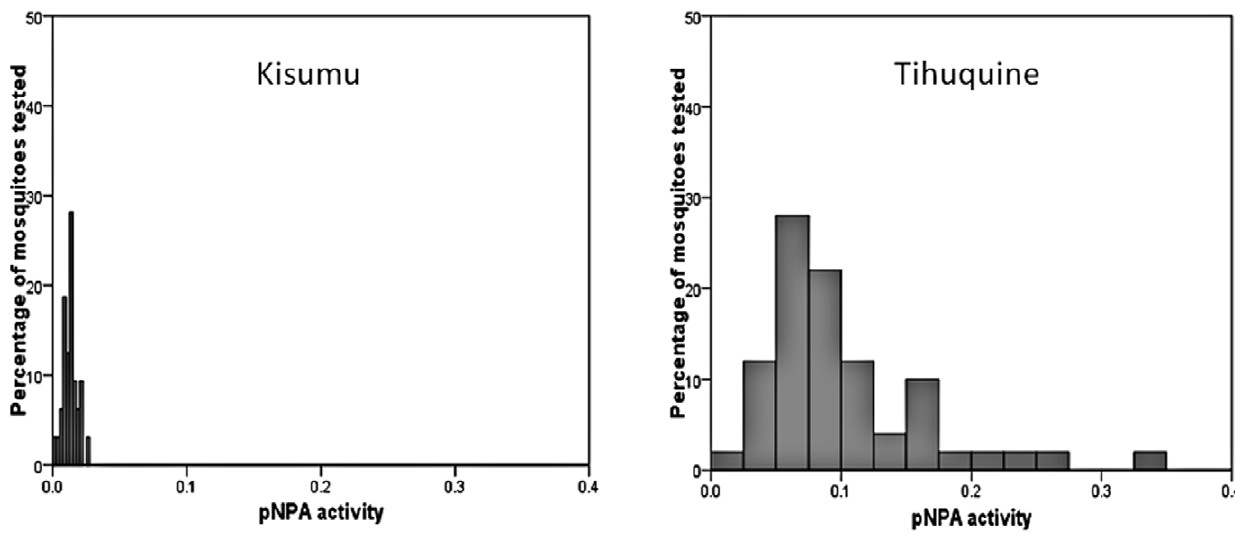
Figure 1. Esterase activity. Range of esterase activity with the substrate p -nitrophenyl acetate in the An. funestus population of Tihuquine compared with An. gambiae Kisumu reference strain.